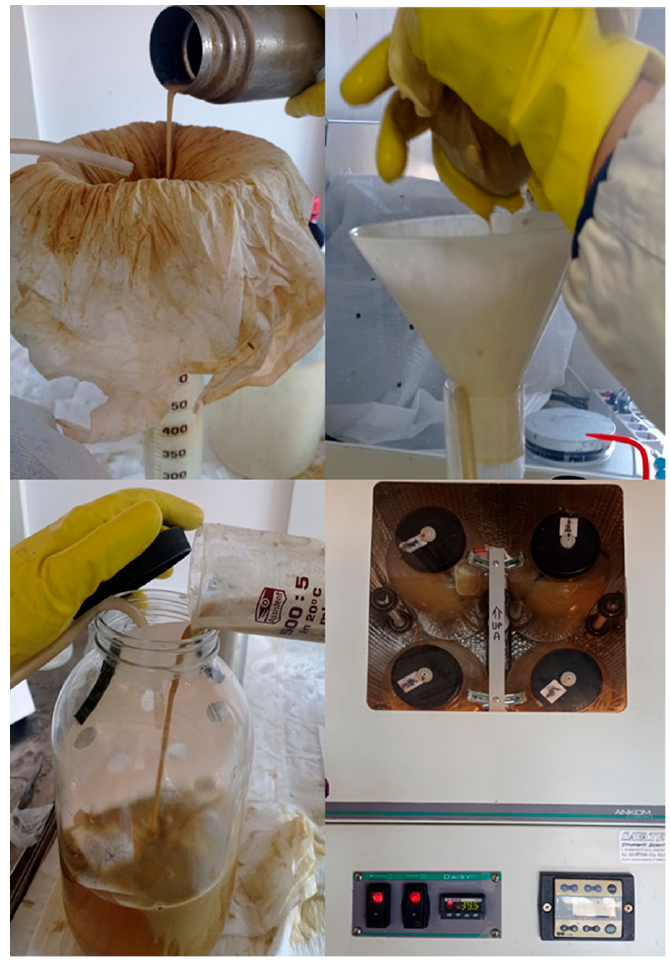
Figure 4. RF collection and incubation with the Ankom Daisy II .